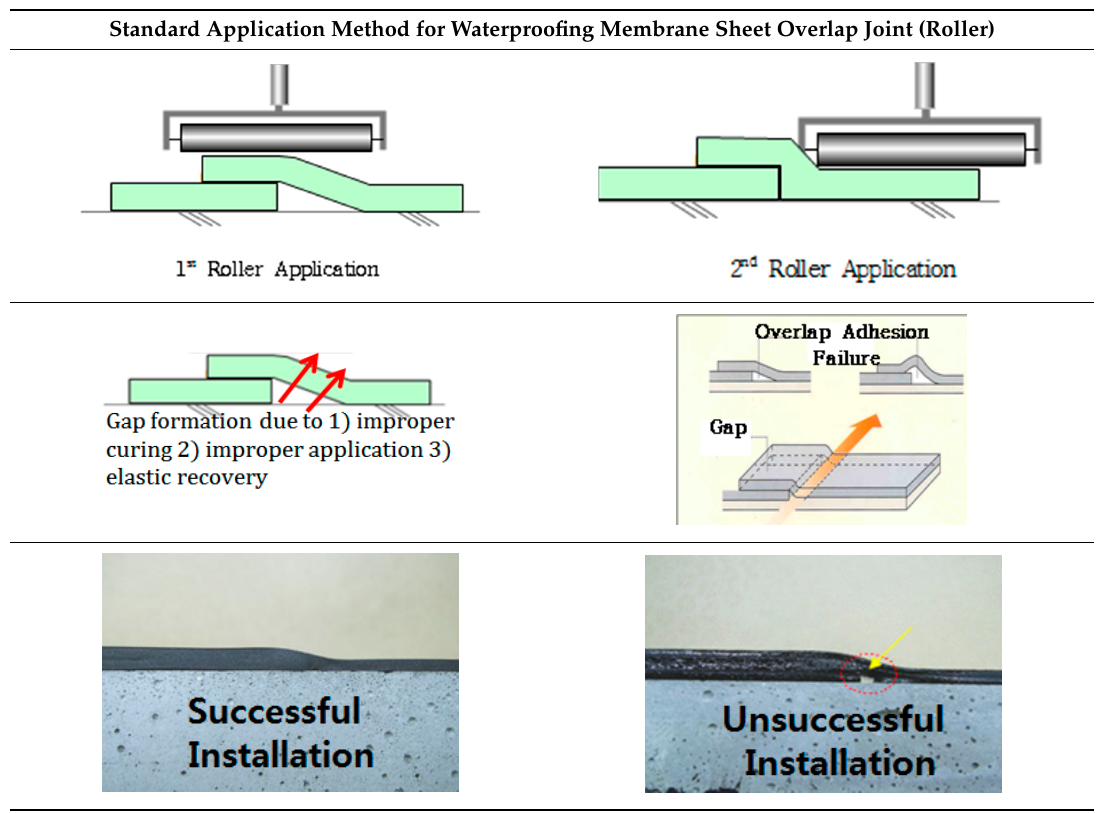
Table 5. Illustration of application method for waterproofing membrane sheet overlap.